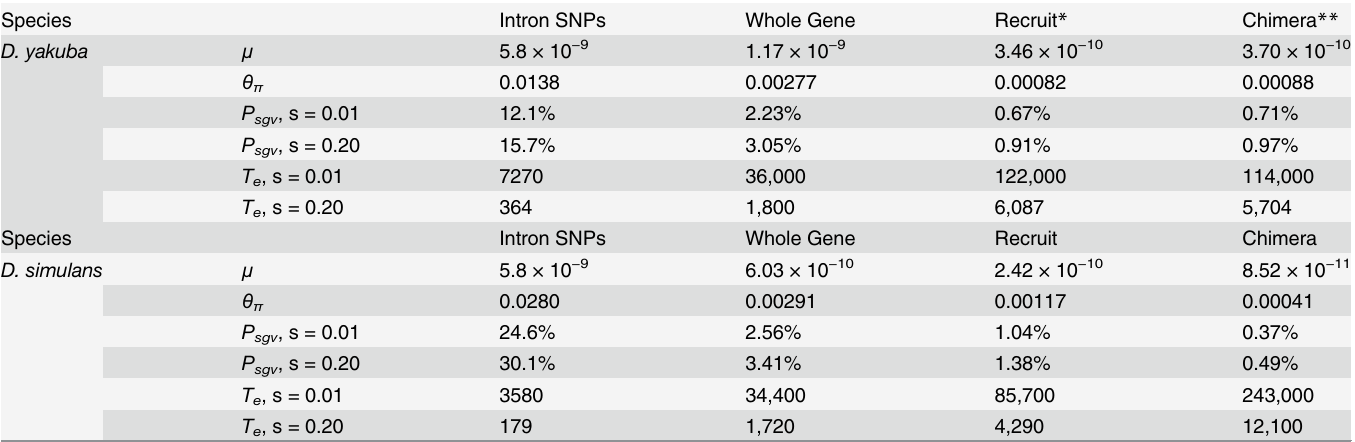
Table 1. Mutation limited evolution in D. yakuba and D. simulans .